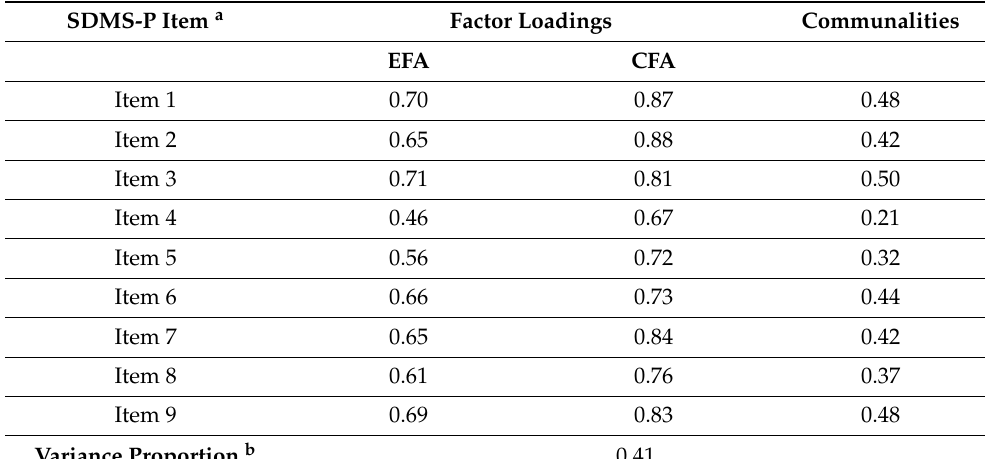
Table 2. Significant factor loadings, communalities, and variance